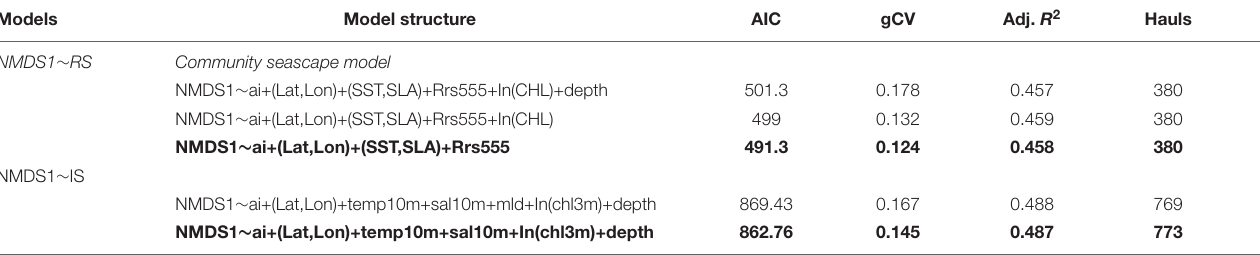
TABLE 3 | Generalized additive mixed model structures and results for models of NMDS axis 1 and NMDS axis 2 with in situ or remotely sensed co-variates and model performance metrics.